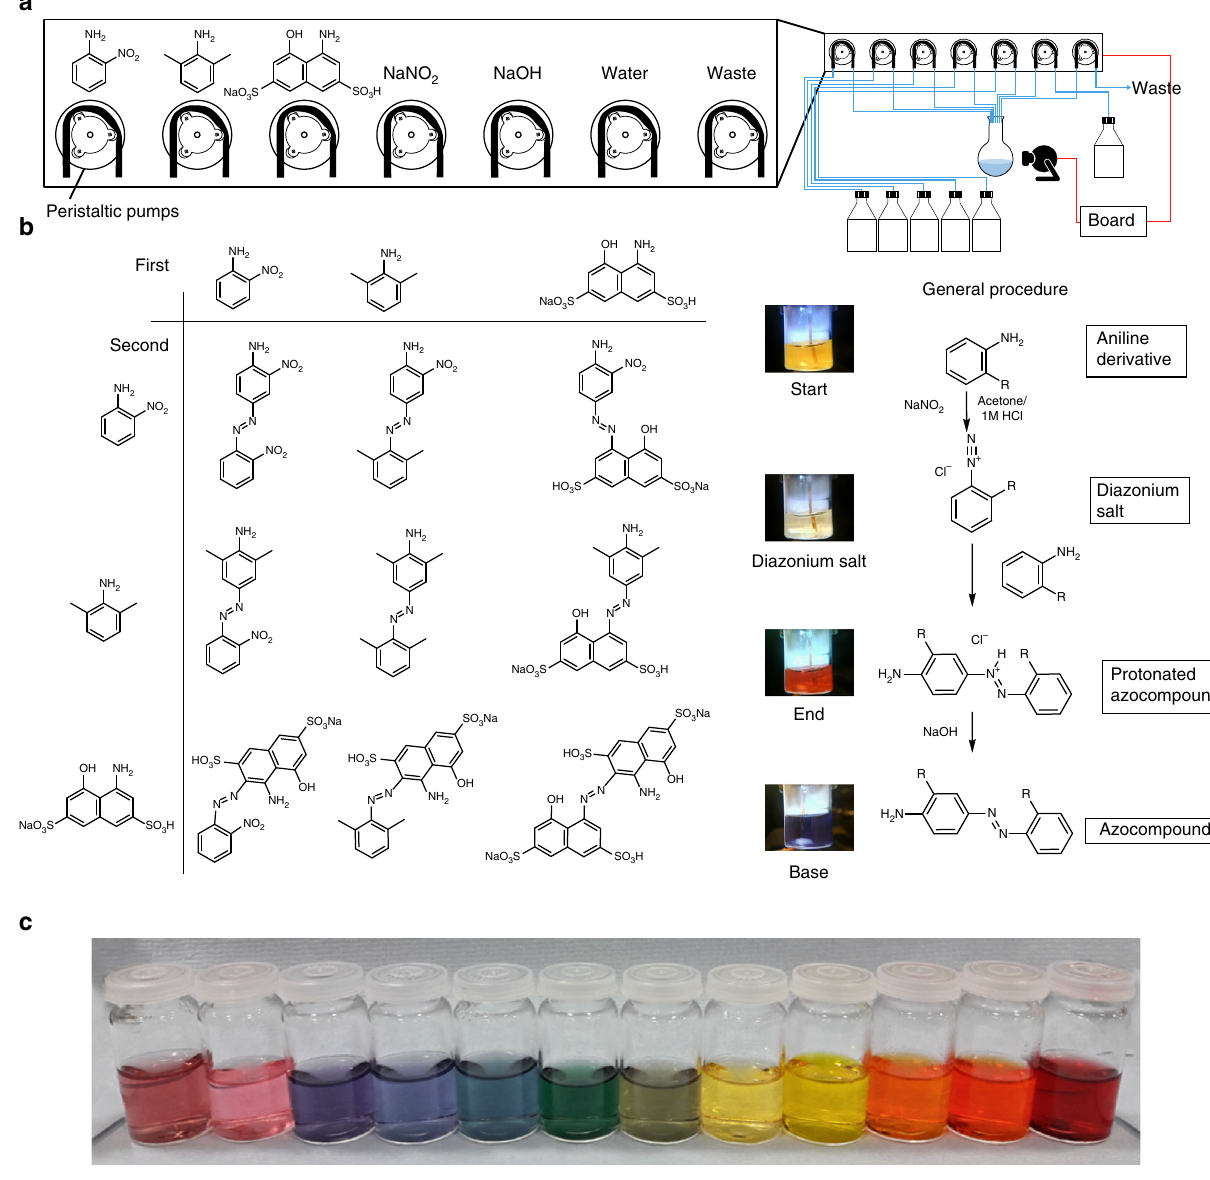
Fig. 3 Organic azo-dye chemical space. a System connections and reagents assignment to the pumps. b Three aniline derivatives were mixed in different order with sodium nitrite in an azo-coupling reaction (general procedure on right-hand side). The starting materials were chosen purposely to be used both as fi rst and second reagents. c The addition of a basic solution to the product and a set of reagent ratios lead to a large variety of